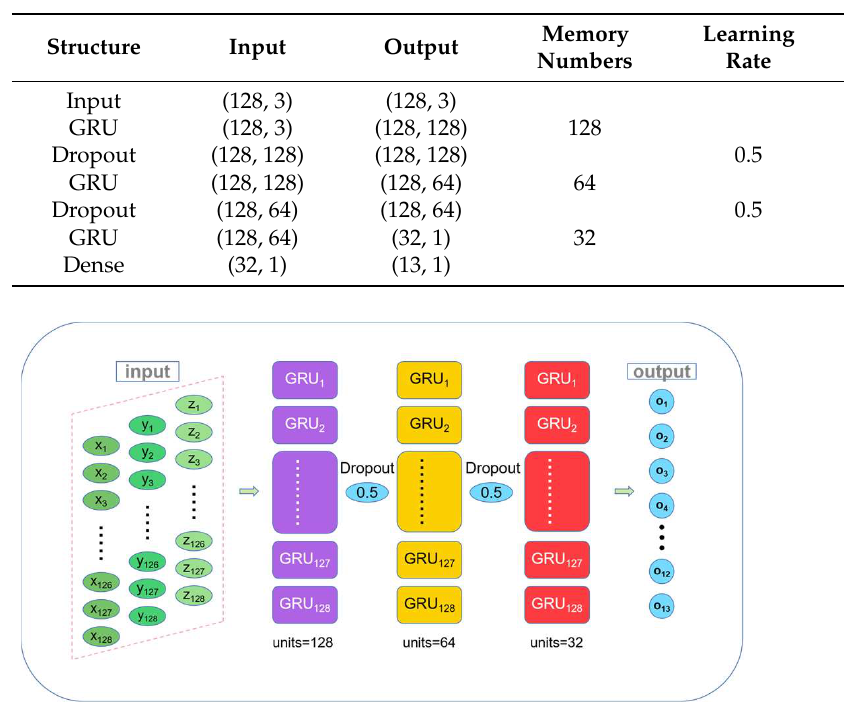
Table 5. The structural parameters of the multi-fault diagnosis network.